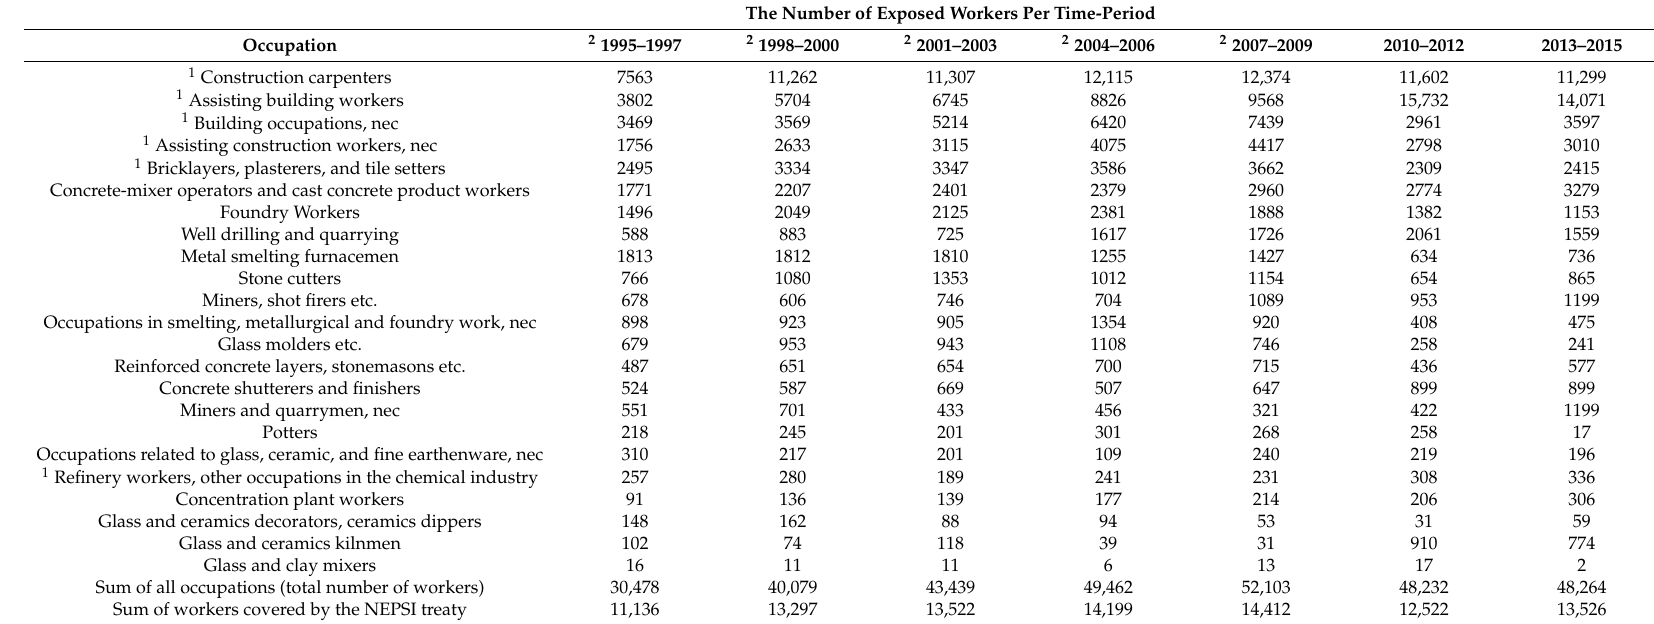
Table 2. Workers exposed to respirable silica according to FINJEM-exposure matrix. The Number of Exposed Workers Per